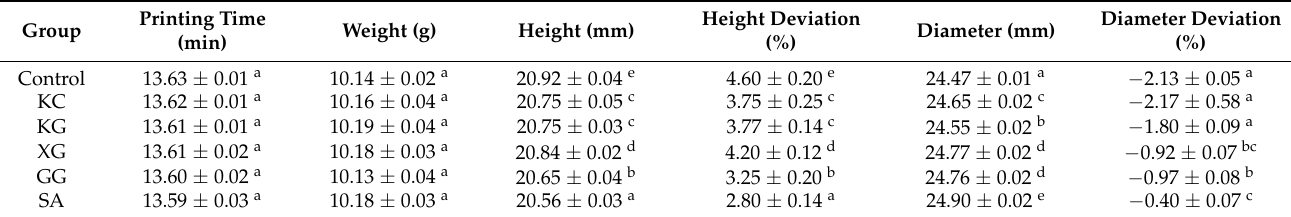
Table 1. Printing time, weight and dimension deviation of raw surimi ink.